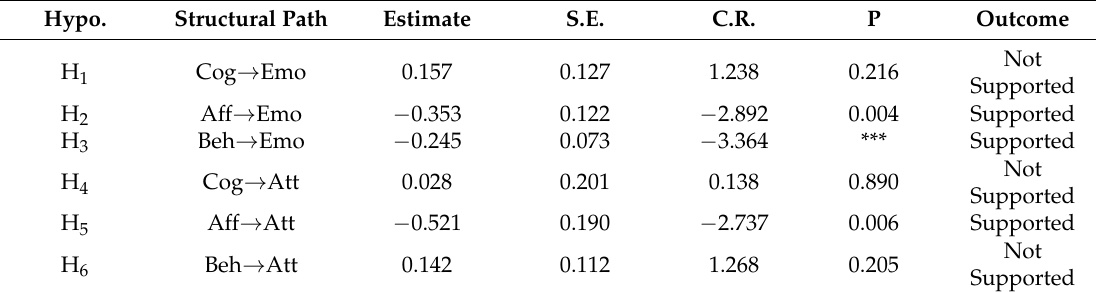
Table 7. Model fit indices